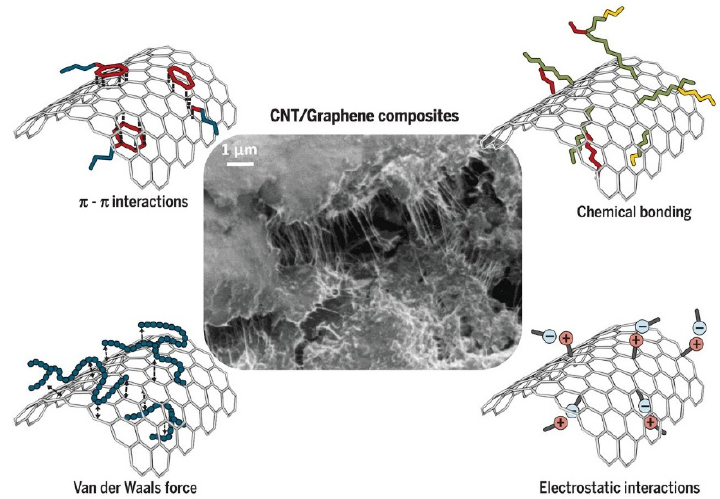
Figure 1. Chemical modification of CNT or graphene via four typical schemes [12].